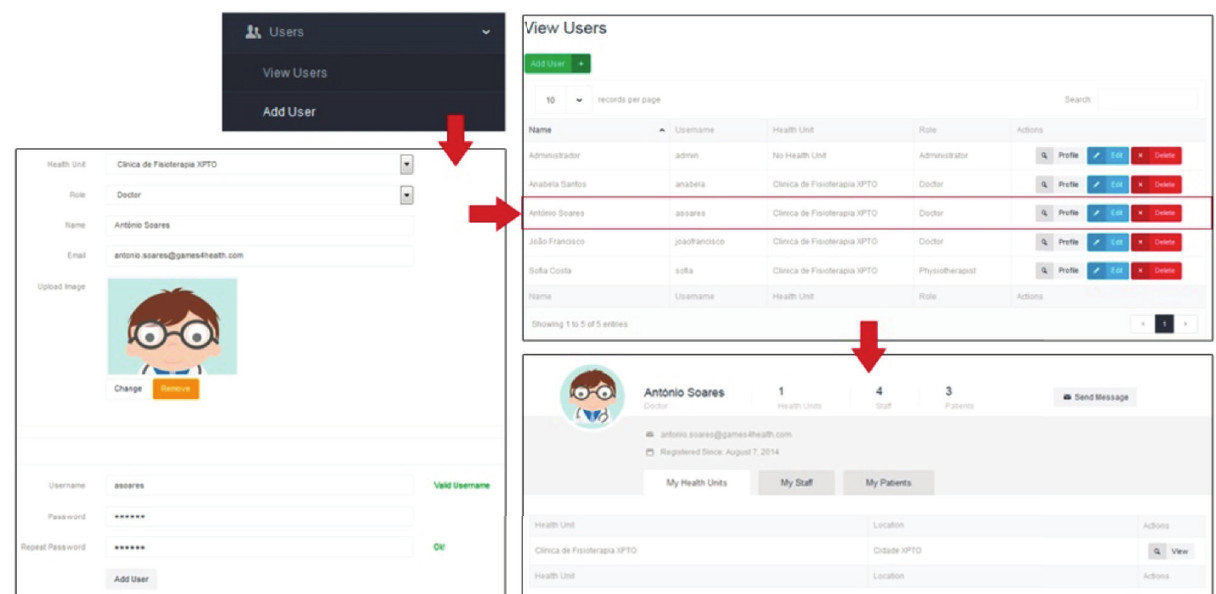
Figure 8: Creating process of a user